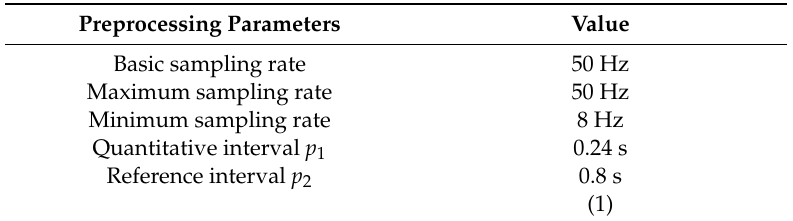
Table 1. Parameters in data acquisition.